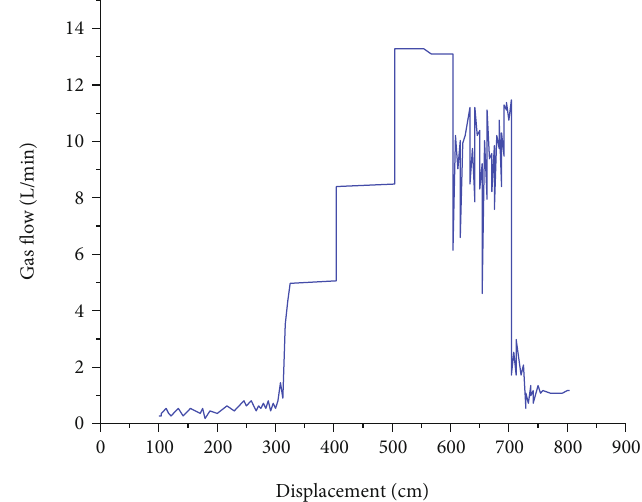
Figure 6: Plot of bore displacement versus gas fl